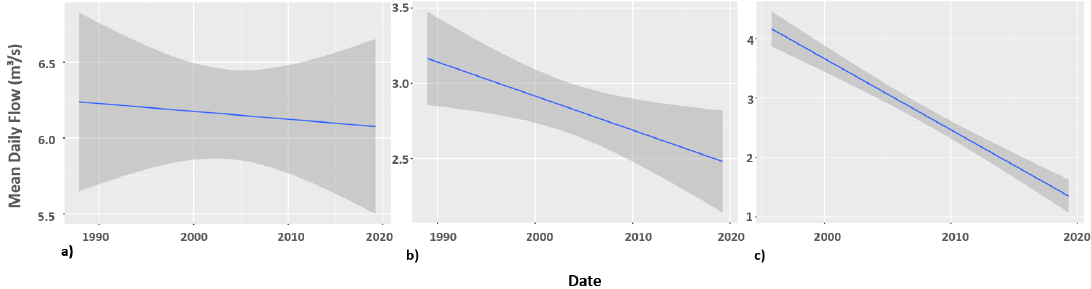
Figure 2. Fitted regressions of time series of streamflow at ( a ) Mhinga, ( b ) Kruger and ( c ) Matsika in